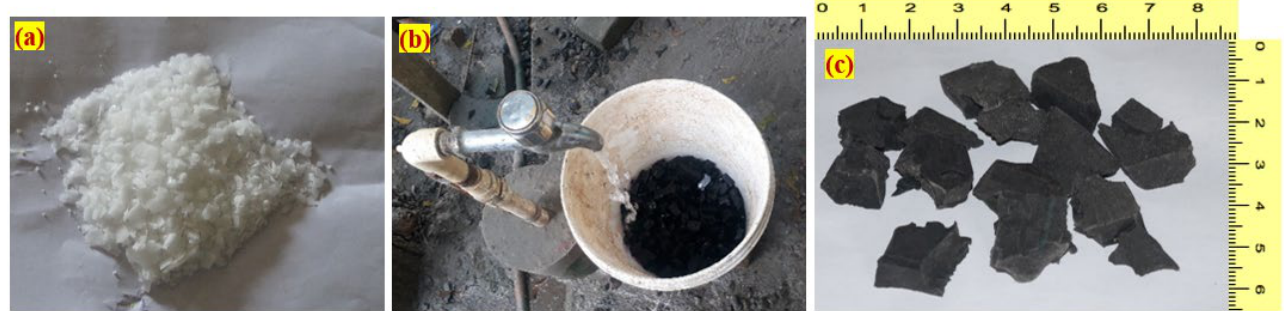
Figure 2. Details of treatment process ( a ) Sodium hydroxide, ( b ) aggregate treated with water containing sodium hydroxide and ( c ) treated rubber.